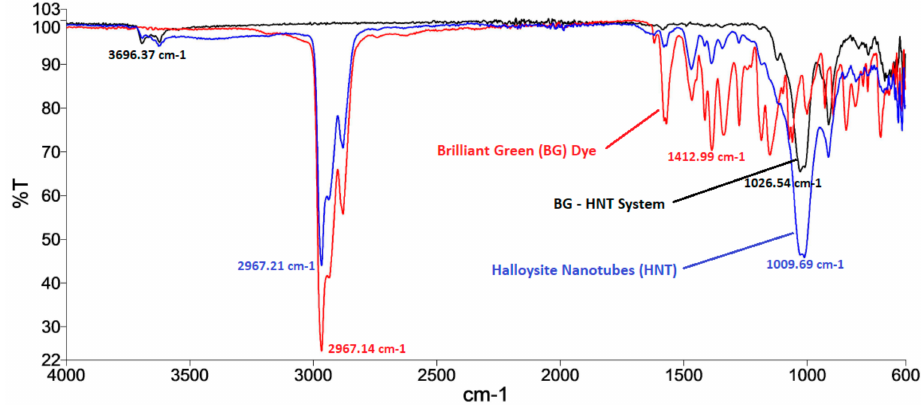
Figure 3. FTIR spectra of BG dye, HNT, and